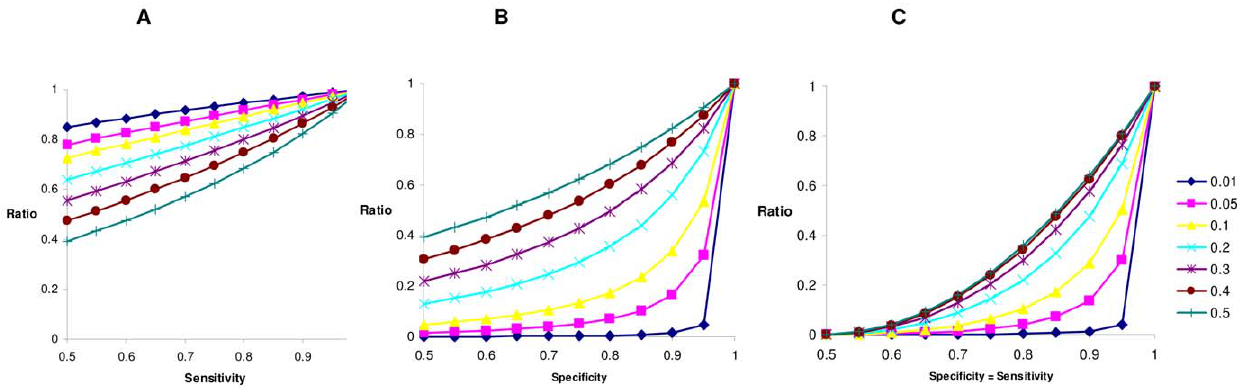
Figure 3. Ratio of estimated to true heritability on the liability scale for differing true prevalences. Results are shown for (A) incomplete sensitivity, where specificity=1, (B) incomplete specificity, where sensitivity=1 or (C) for incomplete specificity and sensitivity, where the two parameters equal. doi:10.1371/journal.pone.0008940.g003 PLoS ONE |